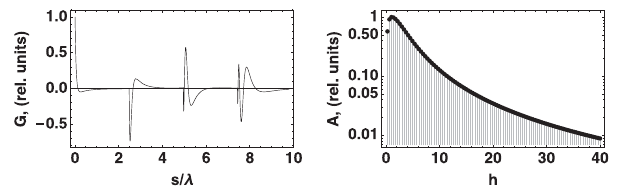
FIG. 6. Green ’ s function (left panel) and spectrum (right panel) normalized on the maximum values for the case of a dielectric lined copper tube with Δ ¼ 4 mm. Here h is the harmonic number, λ is the wavelength of the harmonic with the maximum amplitude.